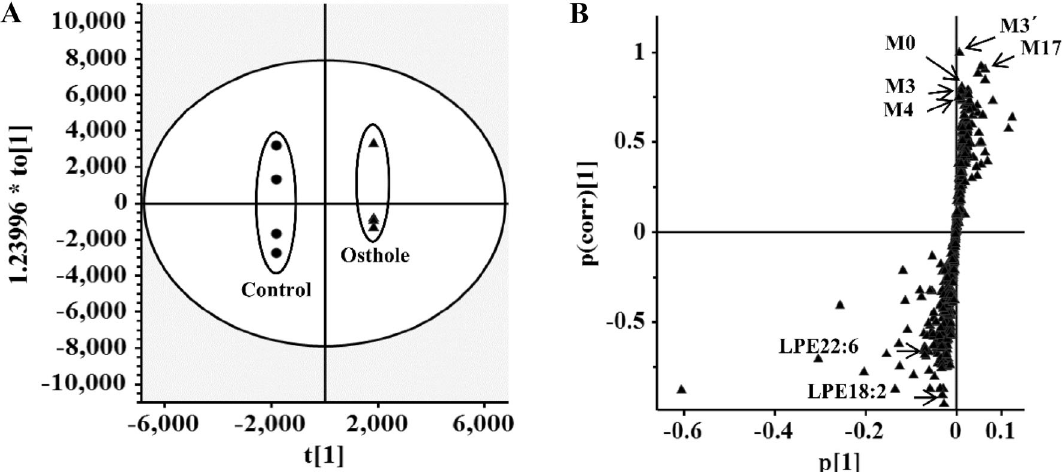
Fig. 5 Analysis of osthole-treated mouse plasma and control group in the positive mode in OPLS-DA score plots ( a ) and S -plot ( b ). Reproduced with permission from